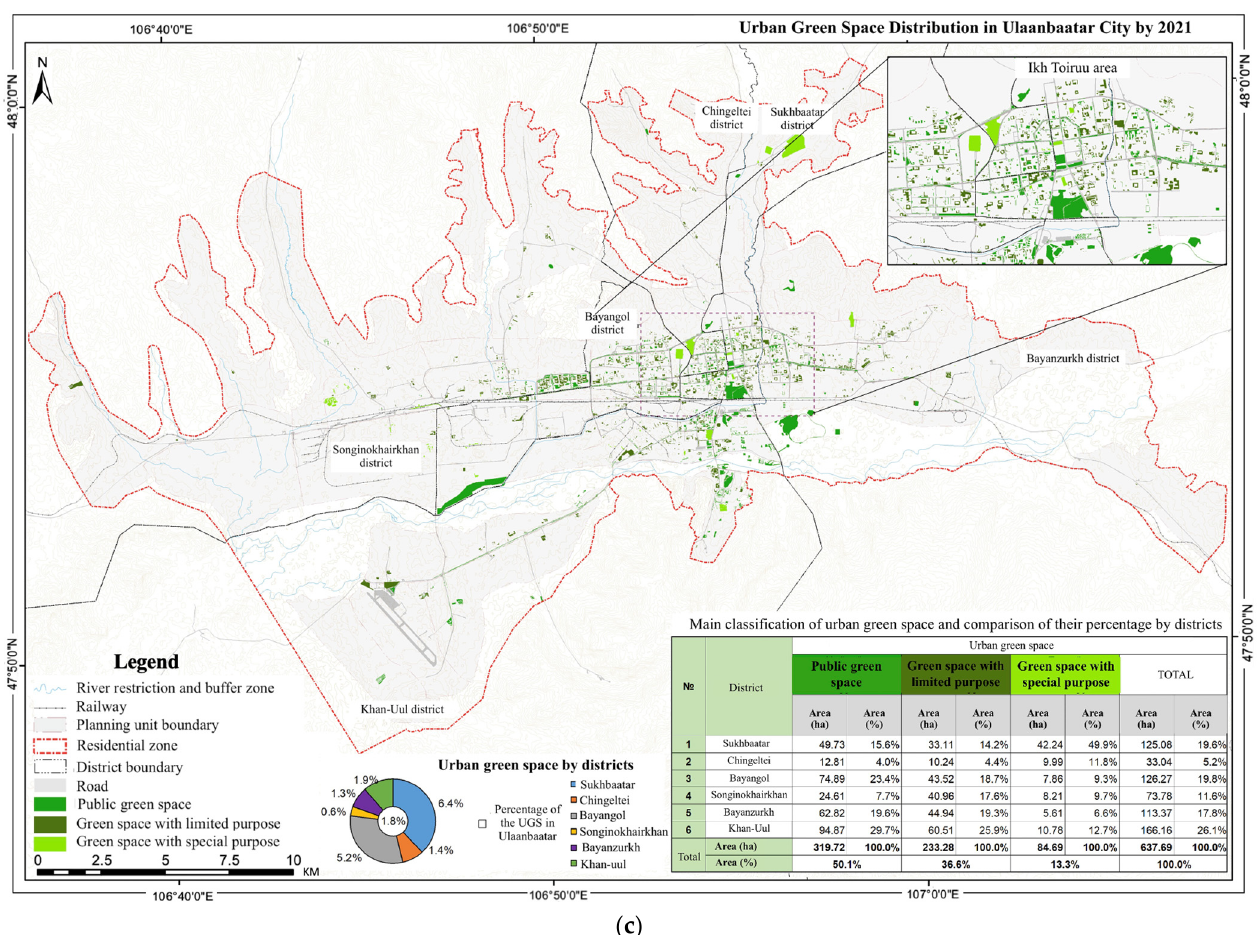
Figure 1. The distribution of urban green space in Ulaanbaatar city. ( a ) Location of Mongolia and Ulaanbaatar city Source: https://geology.com/world/cia-asia-map.shtml (accessed on 25 November 2022). ( b ) Ulaanbaatar city map showing ger and apartment area. Source: https://shonkhor.monmap.mn/ (accessed on 25 November 2022). ( c ) The current distribution of urban green spaces within the residential zone of Ulaanbaatar. Source: Specialists from the Mayor’s Office.